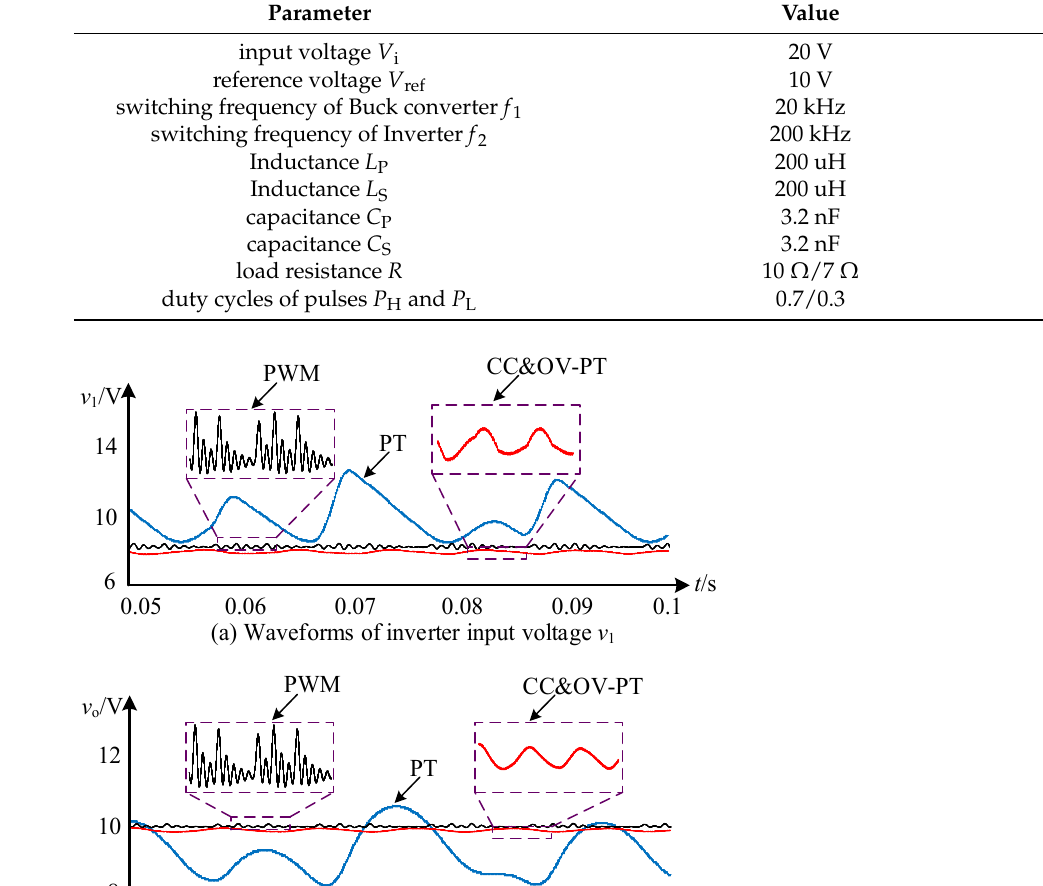
Table 2. The system parameters of numerical models in Simulink environment.